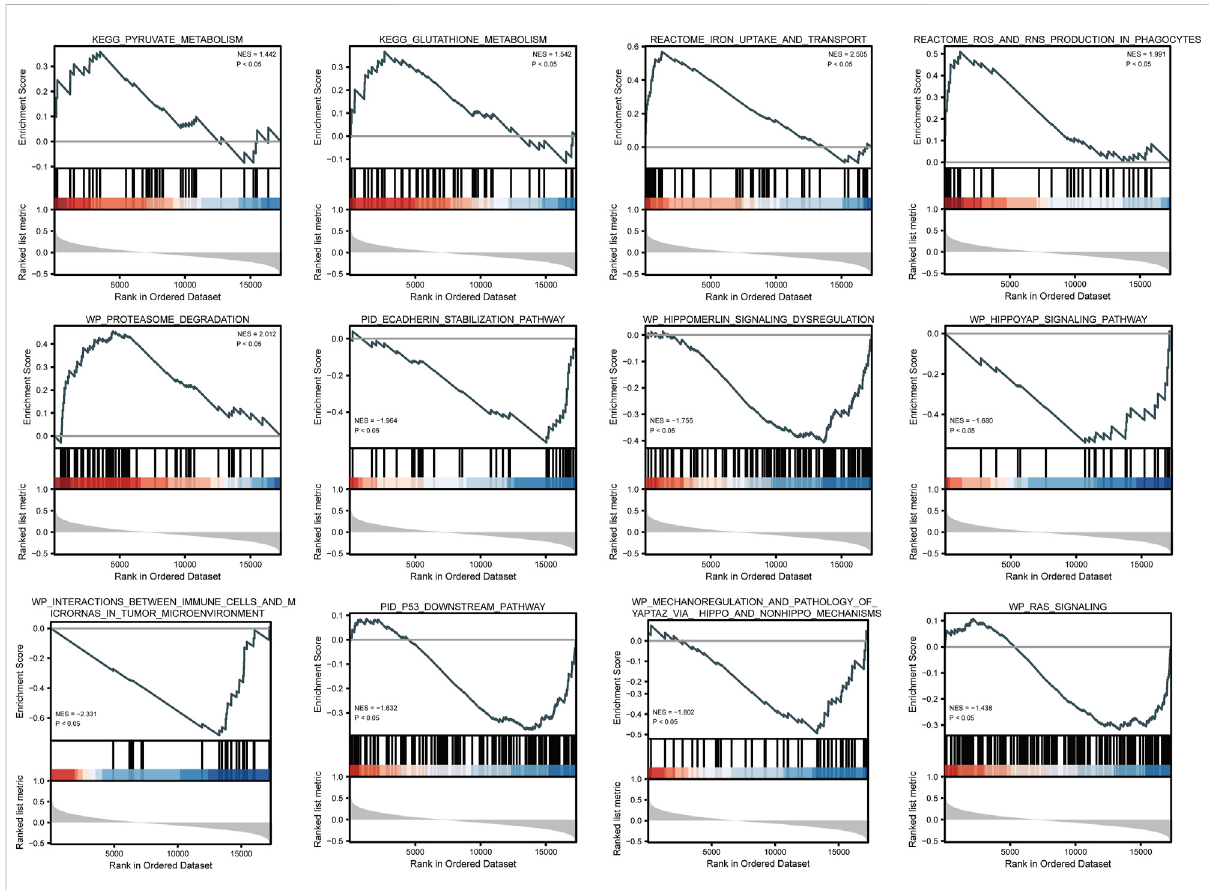
FIGURE 5 GSEA enrichment plots show several pathways were differentially enriched in ATP6AP1-related breast